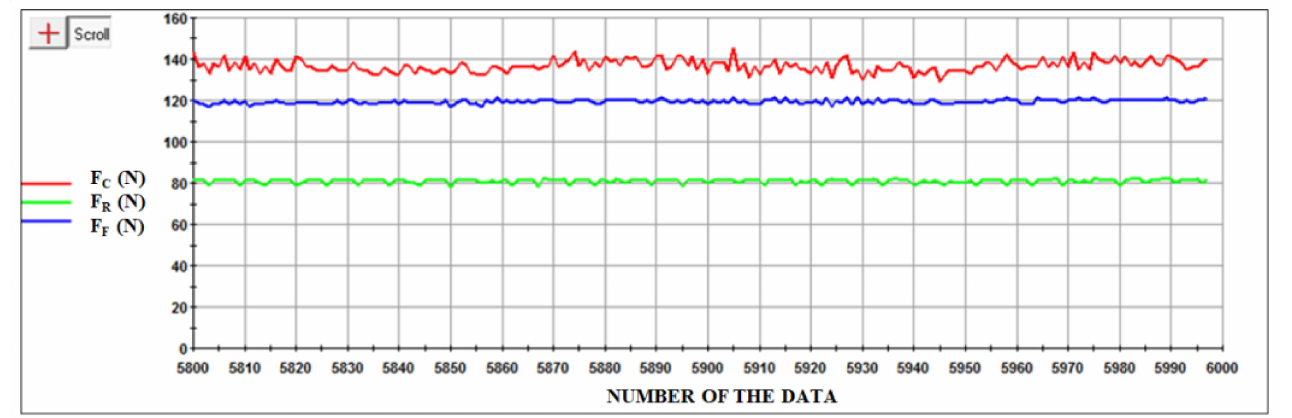
Figure 1. Measured and recorded cutting force data via XKM